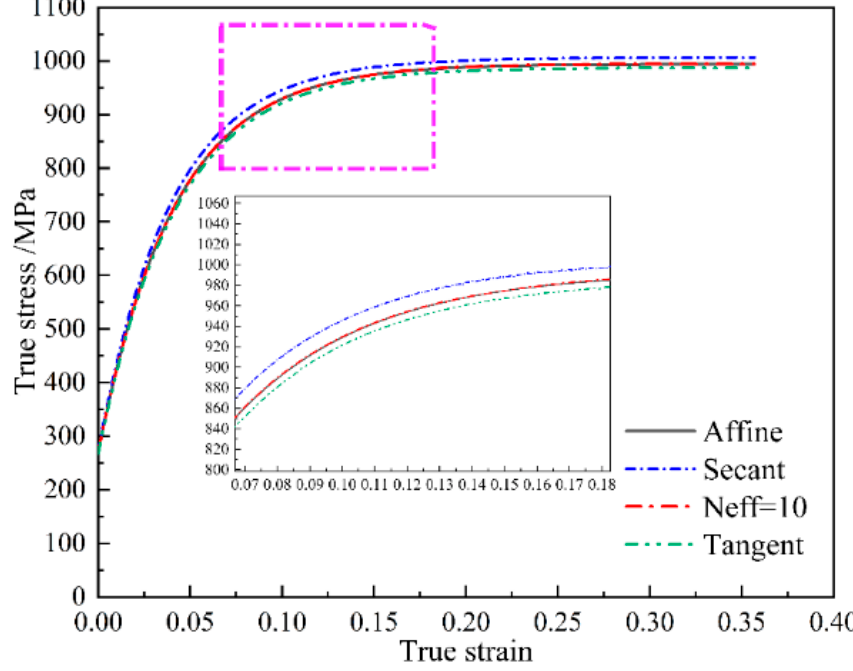
Figure 2. The simulated stress-strain curves in the case of various linearization schemes in the VPSC model during uniaxial compression.